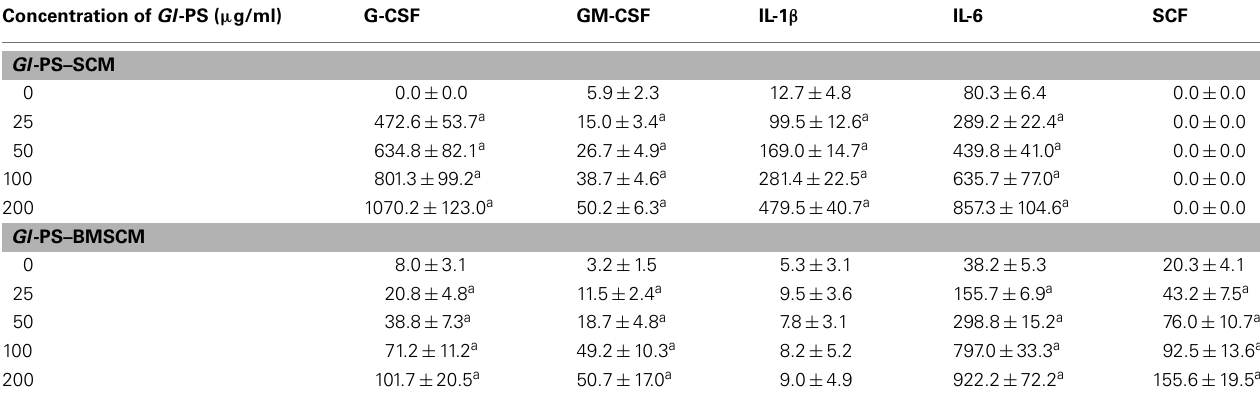
Table 1 | Levels of hematopoietic growth factors in Gl -PS–SCM and Gl -PS–BMSCM. Concentration of Gl -PS ( μ g/ml)